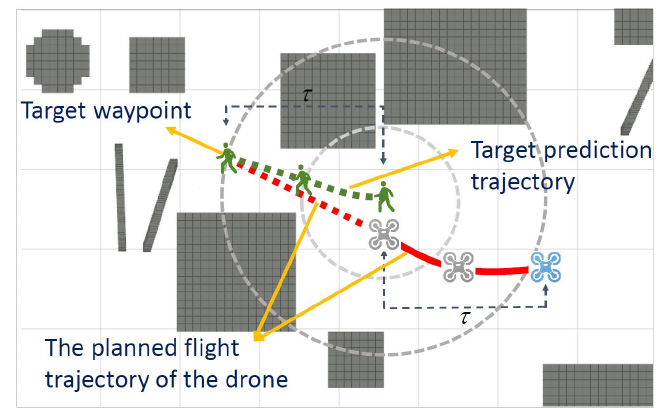
Figure 5. An illustration of the dynamic tracking path searching